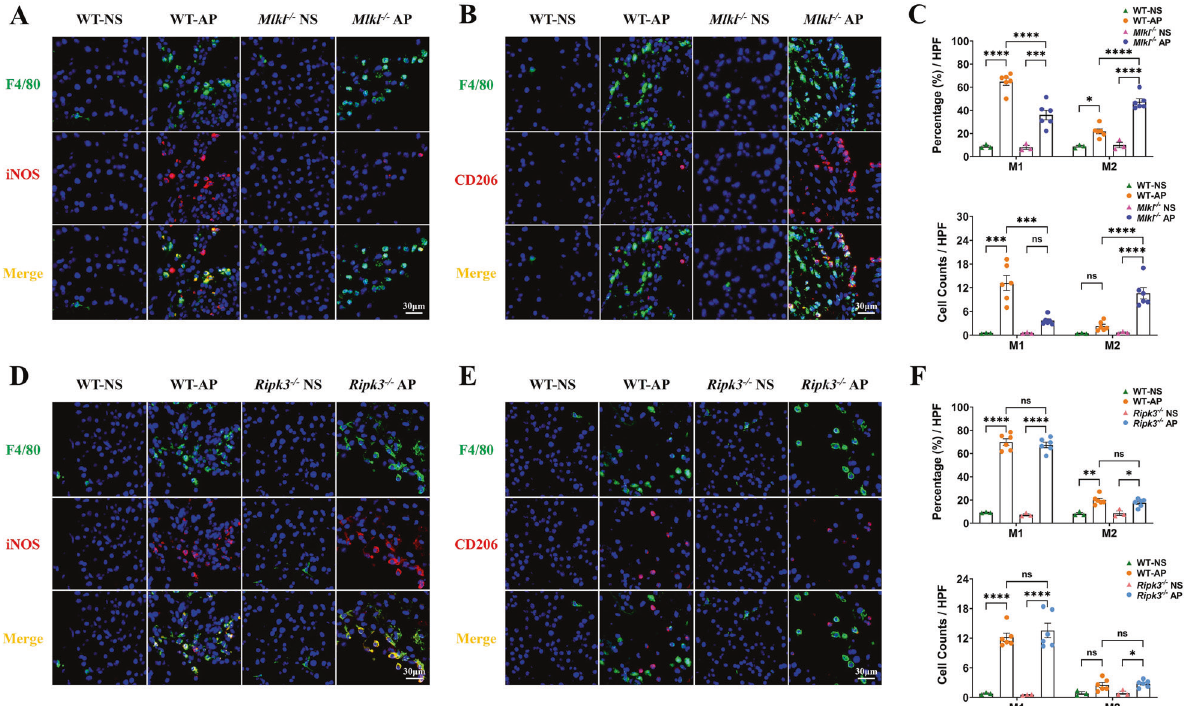
Fig. 4 M1 macrophages are enriched in the pancreas of mice with AP. Knockout of Mlkl decreased M1 macrophages (F4/80 + iNOS + cells) and increased M2 macrophages (F4/80 + CD206 + cells), whereas knockout of Ripk3 did not change the polarization status of macrophages. A , B Immuno fl uorescence staining of F4/80 (green) colocalized with iNOS (red) or CD206 (red) in the pancreas of WT and Mlkl -/- mice ( n = 6). C Percentage and cell counts of M1 and M2 macrophages in WT and Mlkl -/- mice with AP ( n = 6). D , E Immuno fl uorescence staining of F4/80 (green) colocalized with iNOS (red) or CD206 (red) in the pancreas of WT and Ripk3 -/- mice ( n = 6). F Percentage and cell counts of M1 and M2 macrophages in WT and Ripk3 -/- mice with AP ( n = 6). Values are shown as the means ± SEMs. ns, not signi fi cant; * P < 0.05; ** P < 0.01; *** P < 0.001; **** P < 0.0001. WT wild type, NS normal saline, AP acute pancreatitis, HPF high-powered fi eld of